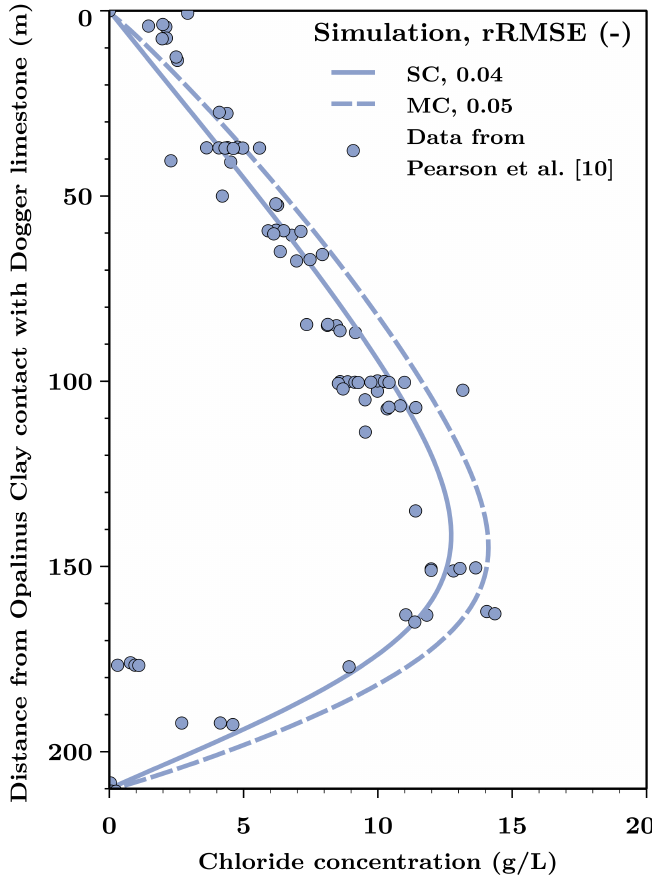
Figure 4. Model calibration for further application. The Chloride profile (dots) was reproduced (rRMSE ≤ 5%) for scenario 1R with an initial chloride concentration of around 18.9g/L using the SC (solid line) as well as the MC diffusion approach (dashed line). Best match using MC diffusion was achieved for an exponent n =